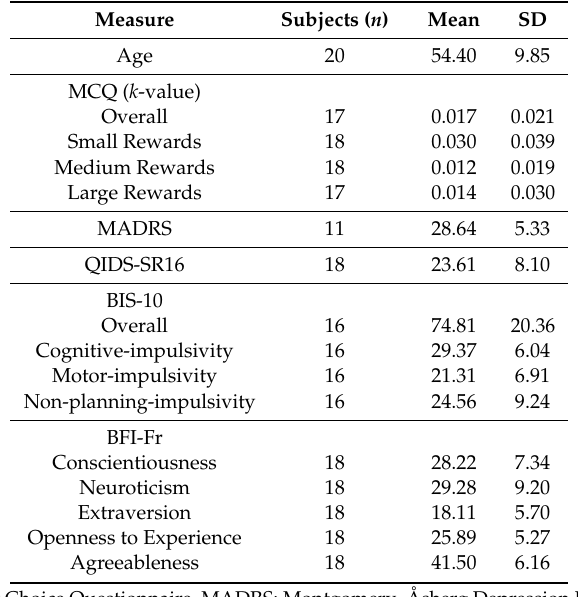
Table 1. Mean scores for quantitative population data and baseline measures.